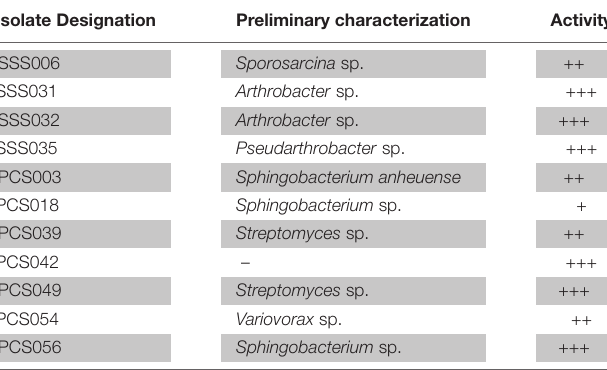
TABLE 1 | Isolate designation, preliminary identification using 16S rRNA analysis, and urease activity.